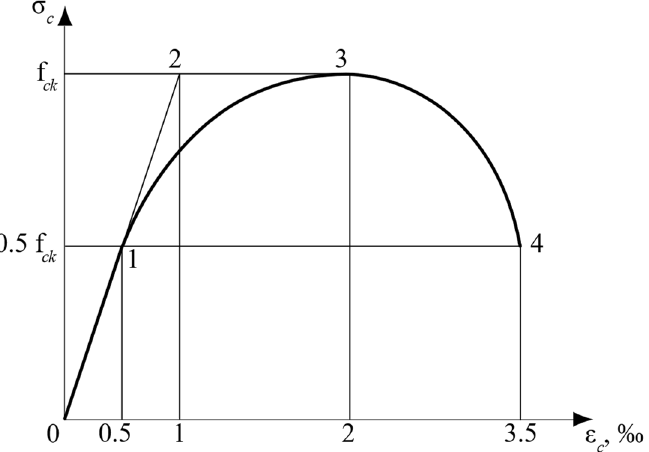
Figure 1. Theoretical compressed concrete stress–strain diagram, following [13,25]: 1. The end of concrete section elastic behavior; 2. section elastic potential under dynamic loading and creep; 3. the initial point of descending branch, which has the same shape as the ascending one; 4. the point determining the full section potential.